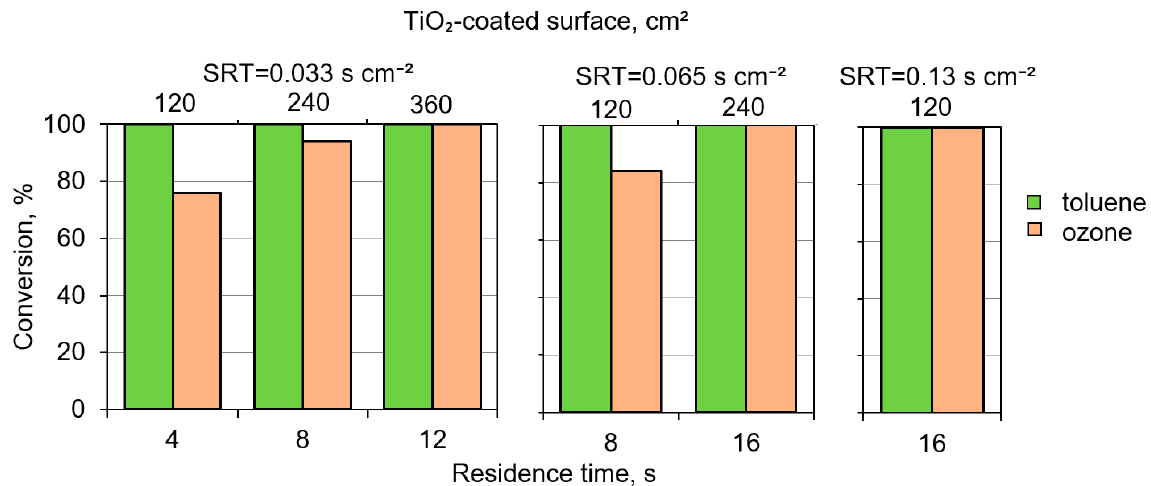
Figure 4. Conversion of airborne toluene and ozone in photocatalytic reactor dependent on residence time at the TiO 2 -coated surface. PCD treatment conditions: C 0 = 3.7 mg·L − 1 (aq), C 0 = 1.0 mg·L − 1 (gas), 200 pps, inital pH 7.0, 20 °C.